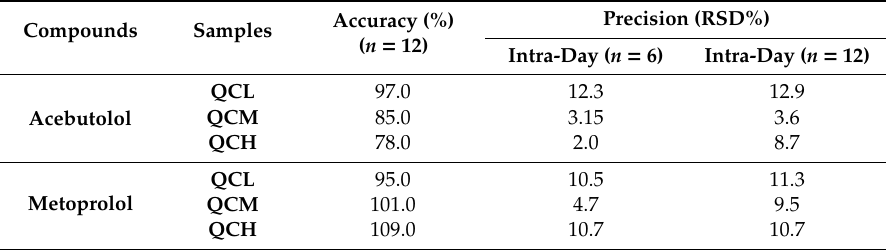
Table 2. Accuracy and precision of the quality control (QC) samples in human